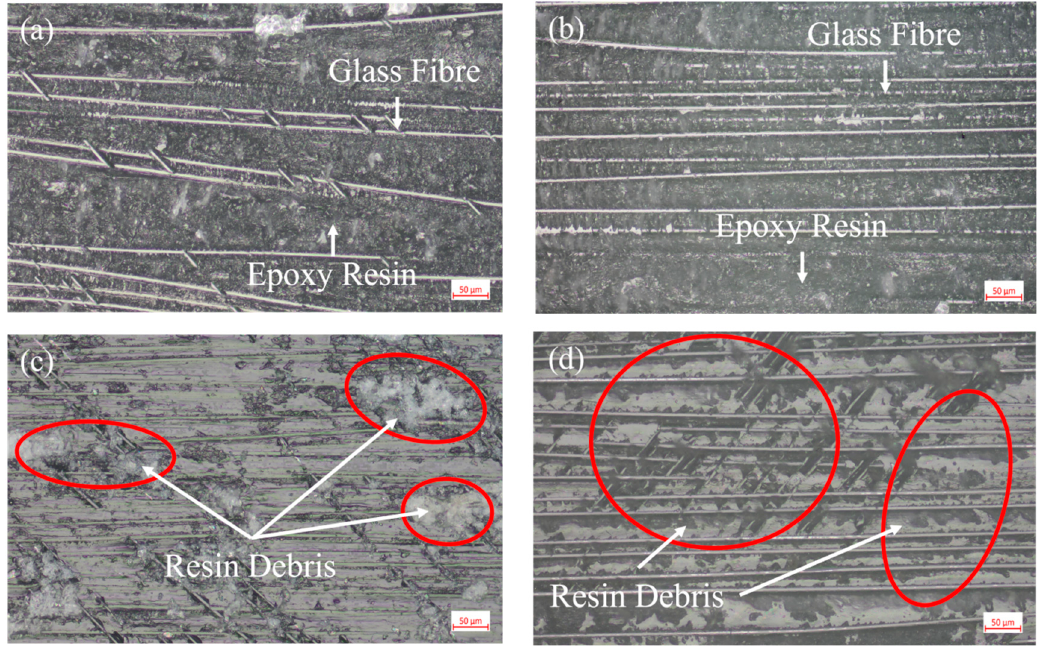
Figure 11. Photomicrographs of the failure surfaces of ENF sample: ( a ) GF/EP infusion sheets that have not undergone flame treatment; ( b ) GF/EP pultruded sheet that has not undergone flame treatment; ( c ) GF/EP infusion sheet after five flame treatments; ( d ) GF/EP pultruded sheet after five flame treatments.